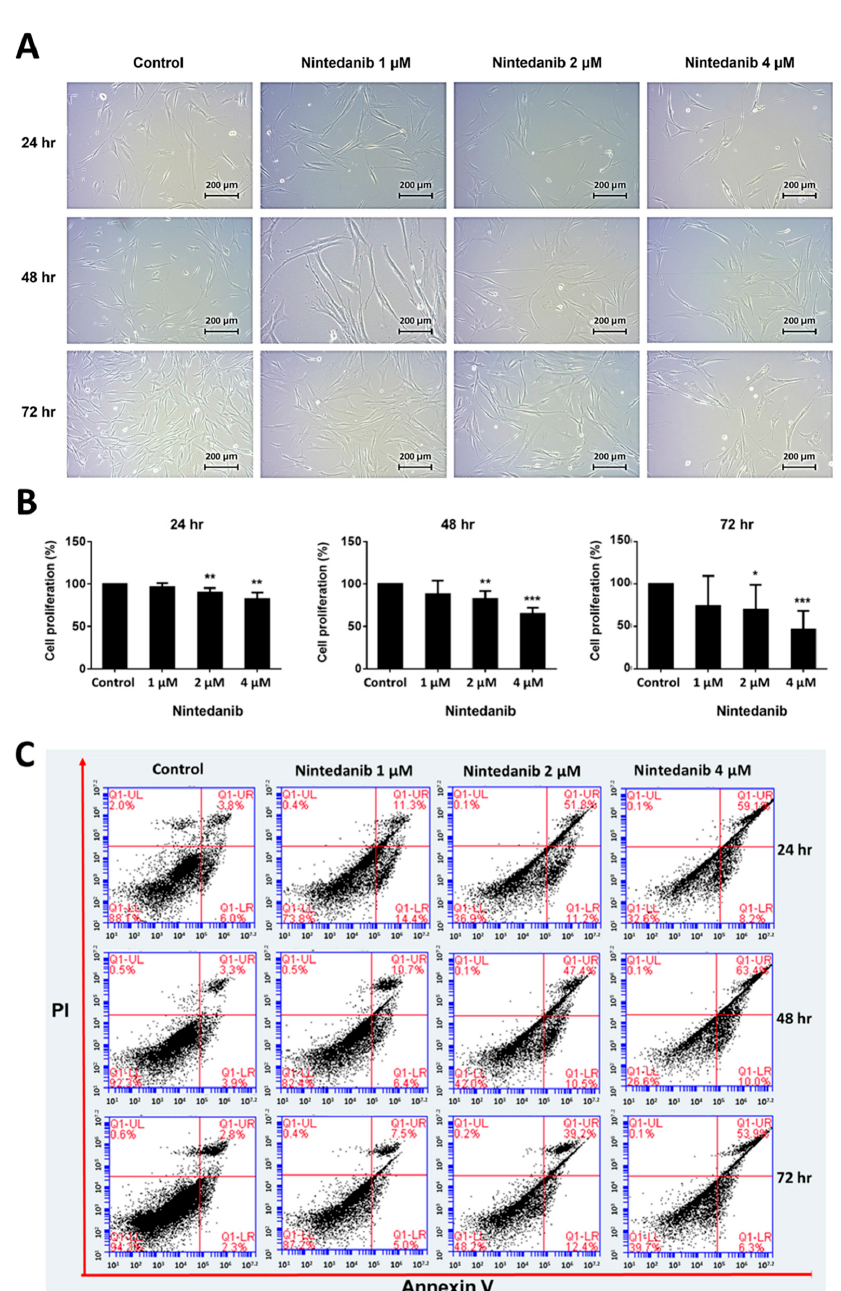
Figure 2. ( A ) Morphological changes of idiopathic pulmonary fibrosis (IPF) fibroblasts after nintedanib treatment. The human IPF lung fibroblasts were treated with 0.1% DMSO (control), 1 µ M, 2 µ M, and 4 µ M nintedanib. The cell morphological changes were observed with an inverted-phase contrast microscope at 24 h, 48 h, and 72 h after nintedanib treatment. ( B ) Inhibition effects of nintedanib on cell proliferation of IPF fibroblasts. The human IPF lung fibroblasts were treated with 0.1% DMSO (control), 1 µ M, 2 µ M, and 4 µ M nintedanib. Cell proliferation was measured with the WST-1 cell proliferation assay at 24 h, 48 h, and 72 h after nintedanib treatment. * p < 0.05; ** p < 0.01; *** p < 0.001. ( C ) Effects of nintedanib on apoptosis of IPF fibroblasts. The human IPF lung fibroblasts were treated with 0.1% DMSO (control), 1 µ M, 2 µ M, and 4 µ M nintedanib. Cell apoptosis was measured with the Annexin V/Propidium Iodide flow cytometry at 24 h, 48 h, and 72 h after nintedanib